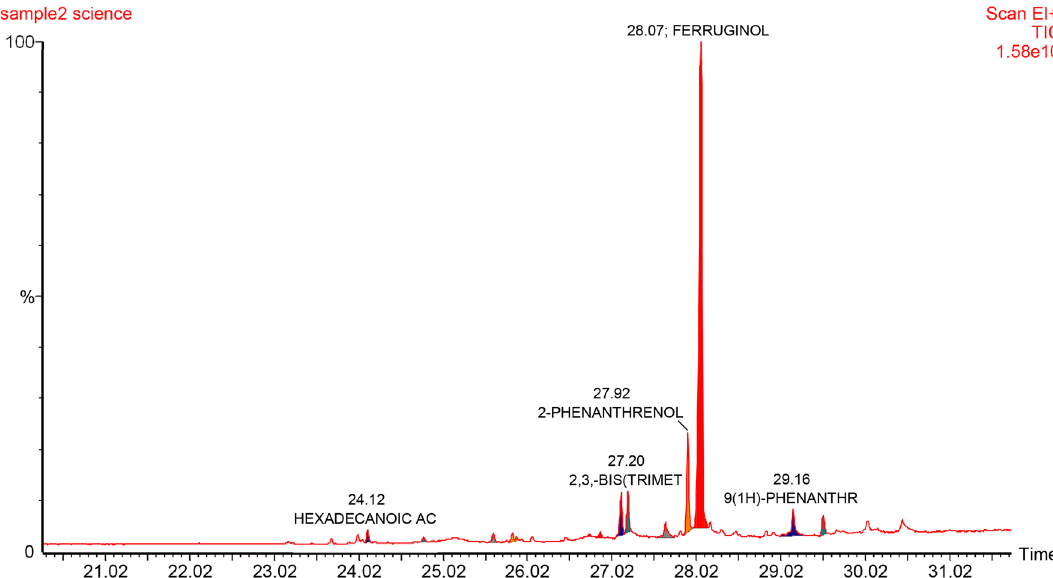
Figure 8. GC–MS analysis chromatograms of callus of J. procera under treatment of ZnO NPs (80